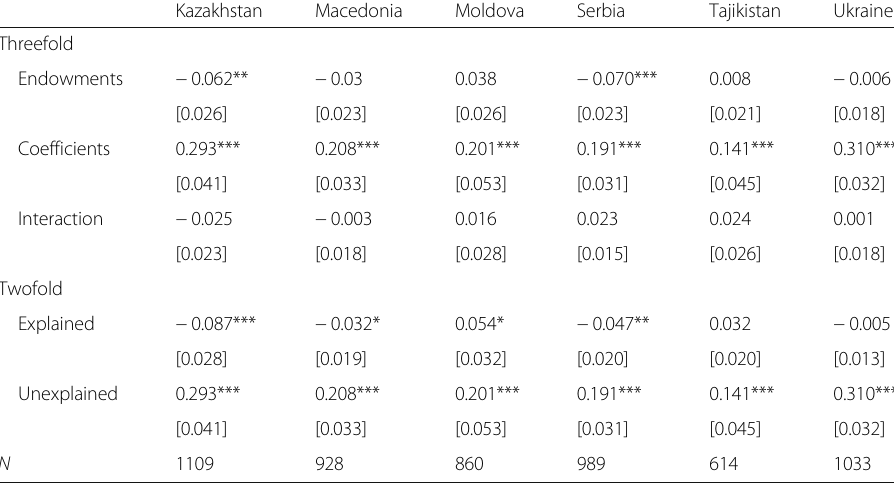
Table 6 Overall income decompositions: three- and twofold Kazakhstan Macedonia Moldova Serbia Tajikistan Ukraine Threefold